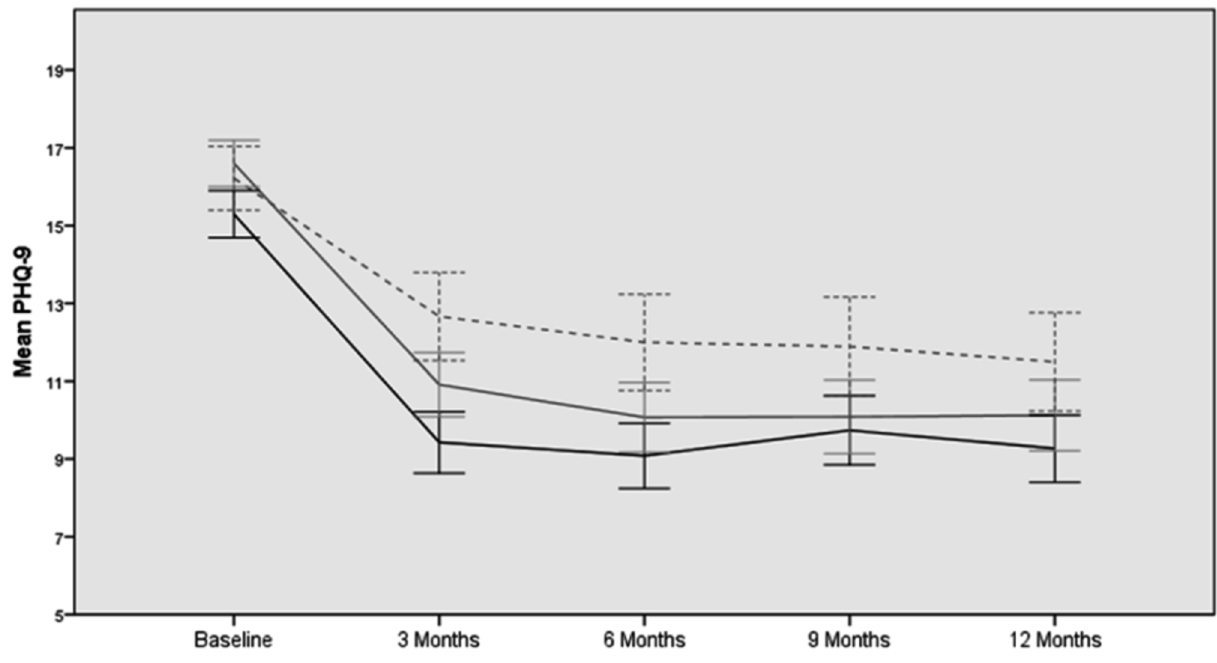
Figure 2. Unadjusted PHQ-9 mean scores from baseline to 12 months. Acupuncture, black line; counselling, grey line; usual care, dashed line.